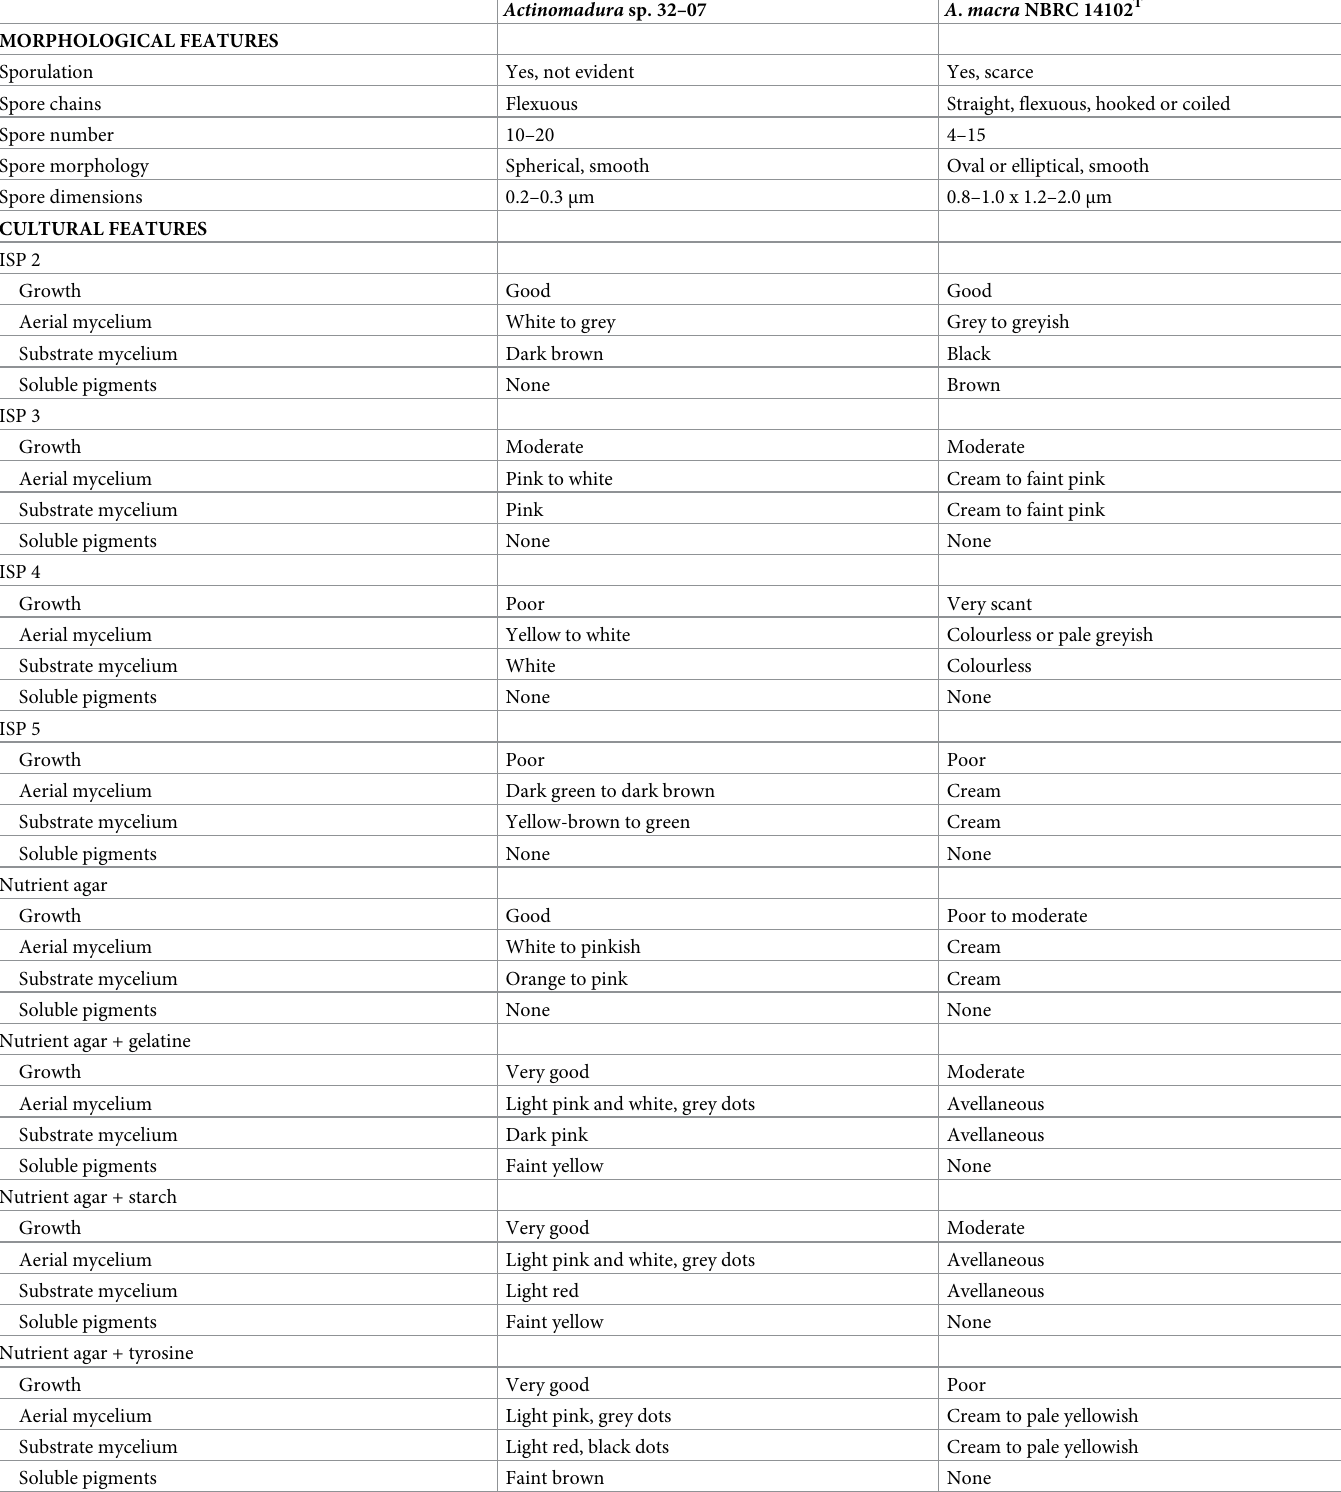
Table 2. Main morphological, cultural and physiological traits that distinguish Actinomadura sp. 32–07 from A . macra NBRC 14102 T